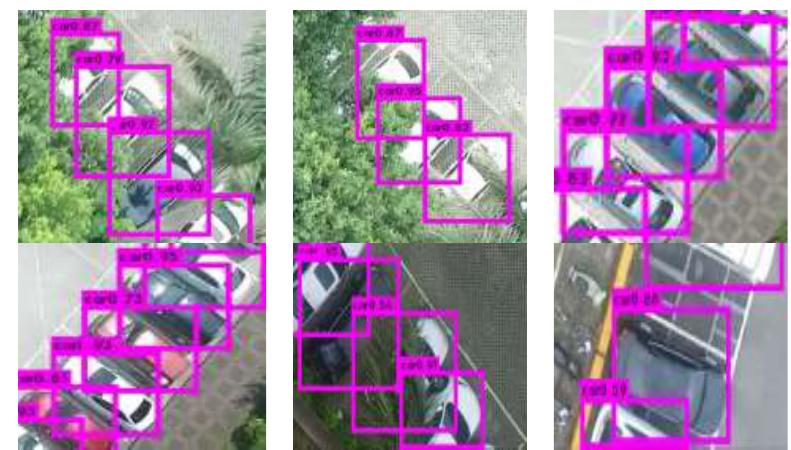
Figure 6. Results after using Soft-NMS. Remote Sens. 2020 , 5 , x FOR PEER REVIEW